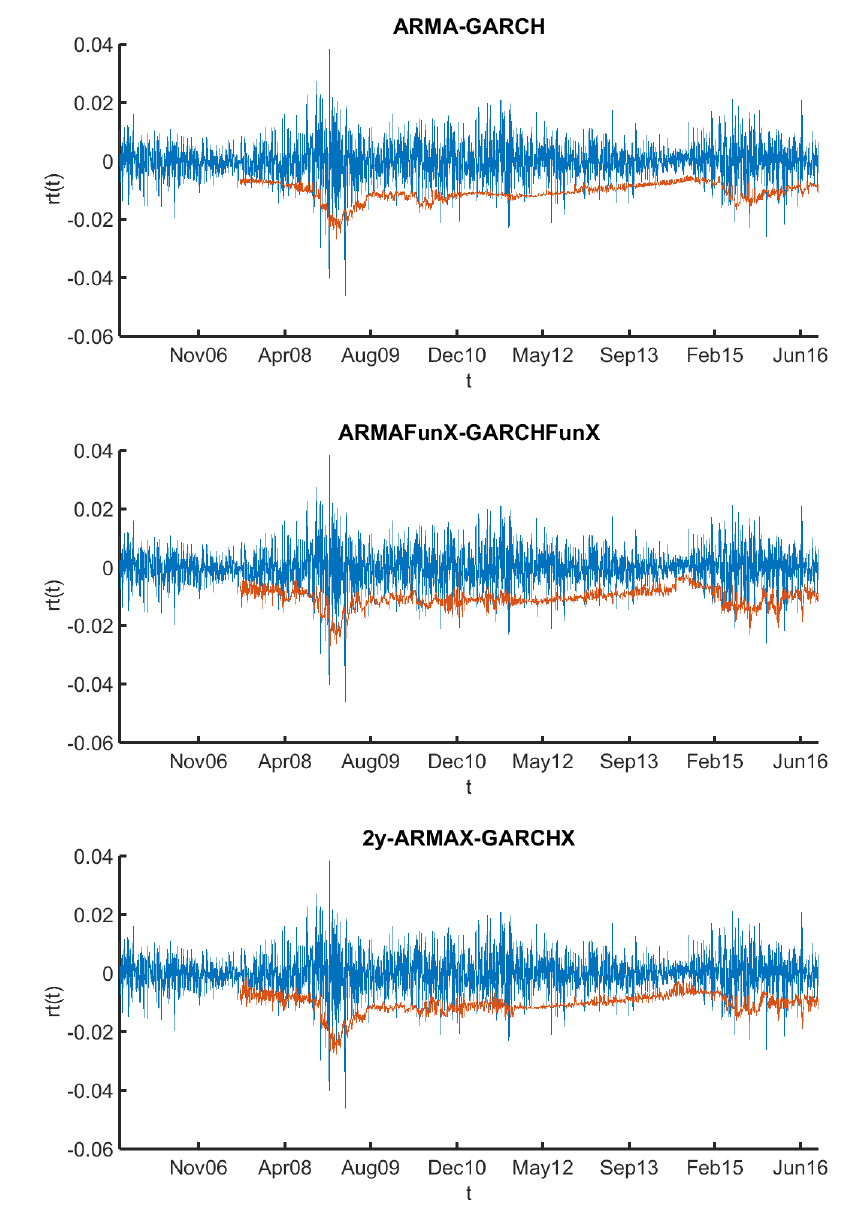
Figure 4. ARMA-GARCH, ARMAFunX-GARCHFunX, 2y-ARMAX-GARCHX: 1-day prediction: